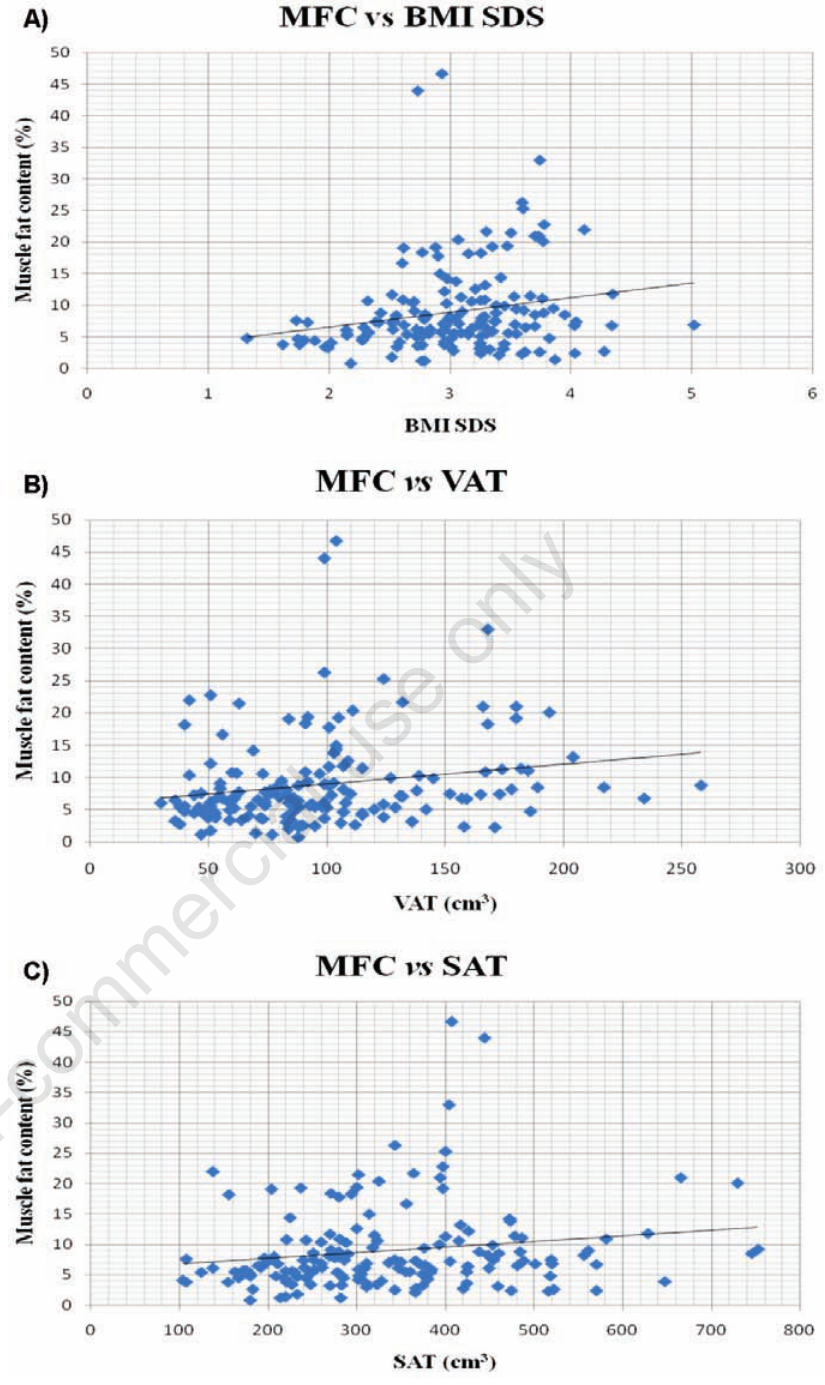
Figure 1. Regression analyses between MFC and BMI SDS, VAT, and SAT in 159 children and youths included in the study. A) Linear regression analysis plot of MFC and BMI SDS with Pearson’s correlation coefficient (r 2 =0.040, 95% CI=[-0.116; 0.194], P=0.012). Equation: y=2.32x+1.90, effect size=2.32, 95% CI=[0.52; 4.12]. B) Linear regression analysis plot of MFC and BMI SDS with Pearson’s correlation coefficient (r 2 =0.039, 95% CI=[-0.117; 0.193], P=0.013). Equation: y=0.03x+5.92, effect size=0.03, 95% CI=[0.01; 0.06]. C) Linear regression analysis plot of MFC and BMI SDS with Pearson’s correlation coefficient (r 2 =0.029, 95% CI=[-0.127; 0.184], P=0.031). Equation: y=0.01x+5.85, effect size: 0.01, 95% CI=[0.00; 0.02]. MFC, muscle fat content; BMI, body mass index; SDS, standard deviation score; VAT, visceral adipose tissue volume; SAT, subcutaneous adipose tissue